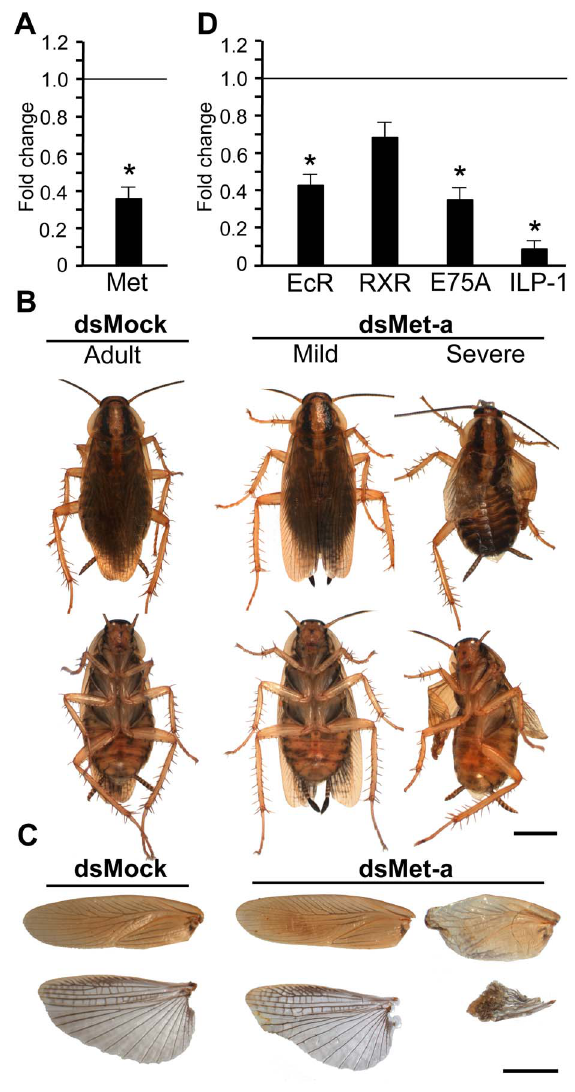
Figure 2. Effects of BgMet depletion in last nymphal stage of Blattellagermanica . (A) Effects at transcript level; N6 females received two 3- m g doses of dsMet-a, one on N6D0 and the other on N6D3, and Met mRNA levels were measured on N6D6; controls received an equivalent treatment with dsMock. (B) Dorsal and ventral view of specimens resulting from dsMet-a treatment in N6; normal adult obtained from dsMock treatments; mild and severe adult phenotypes obtained after Adult N6 with adultoid features, mild and severe, obtained from dsMet-a treatments. (C) Tegmina and membranous wings corresponding to normal adult obtained after dsMock treat- ments, and to adults treated with dsMet-a showing the mild and the severe phenotype. (D) Effects of Met depletion on N6 on the expression of EcR, RXR, E75A and ILP-1 measured on N6D6. In A and D, each point represents 4 biological replicates and results are expressed as the mean 6 SEM; data are normalized against the dsMock-treated samples (reference value=1), and the asterisk indicates statistically significant differences with respect to controls (p , 0.05), according to the REST software tool [29]. Photomicrographs in B–C were with a Zeiss DiscoveryV8 Stereo microscope with an AxioCam MRc digital camera; scale bars=3